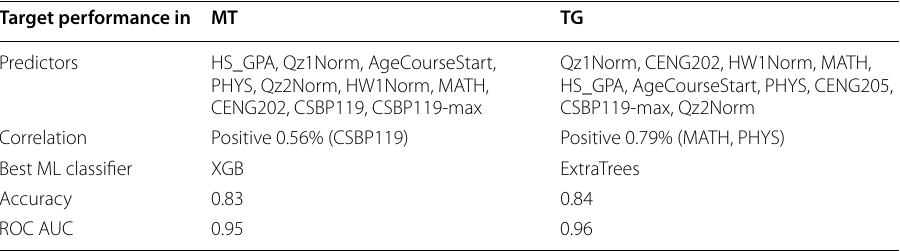
Table 6 Performance of the classification model in predicting students’ groups from prior knowledge and course checkpoints in dataset